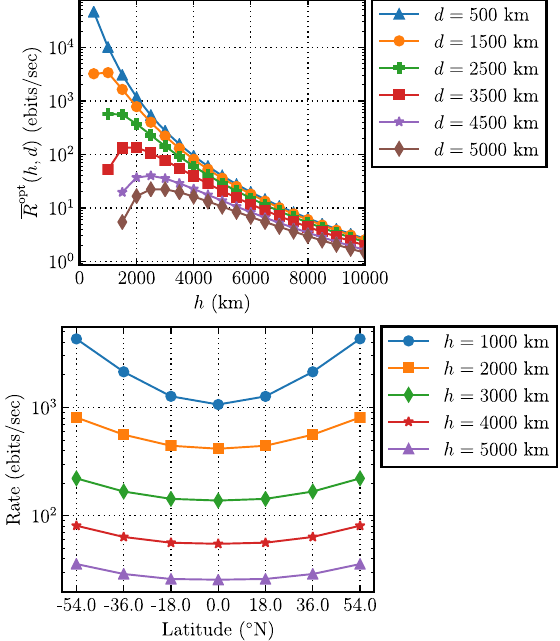
Fig. 5 Average entanglement-distribution rates (over 24 h) for two ground stations for various satellite constellations. In all cases, we assume that the satellites transmit entangled photon pairs at a rate of R source = 10 9 ebits/s 100 . Top — optimal rate (as de fi ned in eq. (1)) among all satellite con fi gurations considered for two ground stations at the equator separated by a distance d . Each point in the plot corresponds to N R = 20 satellite rings and N S = 20 satellites per ring, because we fi nd that this con fi guration achieves the maximum in eq. (1). Bottom — both ground stations at various latitudes. The ground stations are separated by approximately 18° in longitude. The satellite constellation consists of N R = 15 satellite rings with N S = 15 satellites per